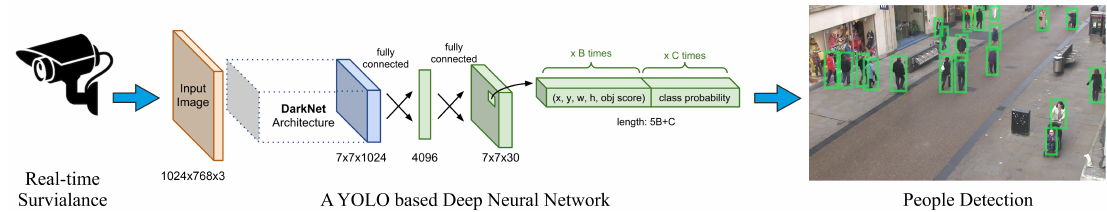
Figure 4. Stage 1—The overall structure of the people detection module.